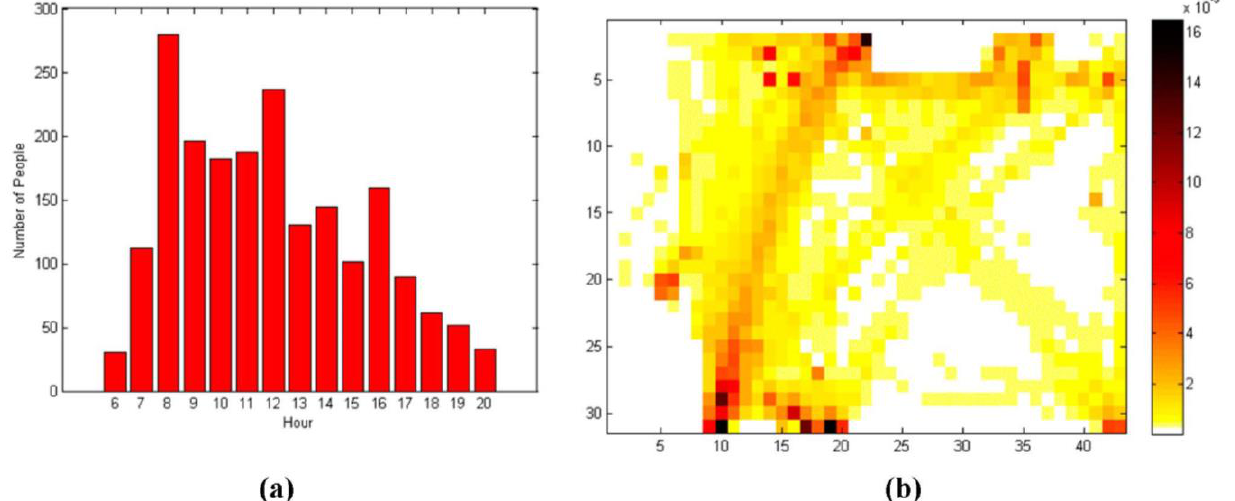
Figure 10. Scene Information ( a ) Distribution of people through the scene over time; ( b ) The actual heat map of traffic from 8 a.m.–9